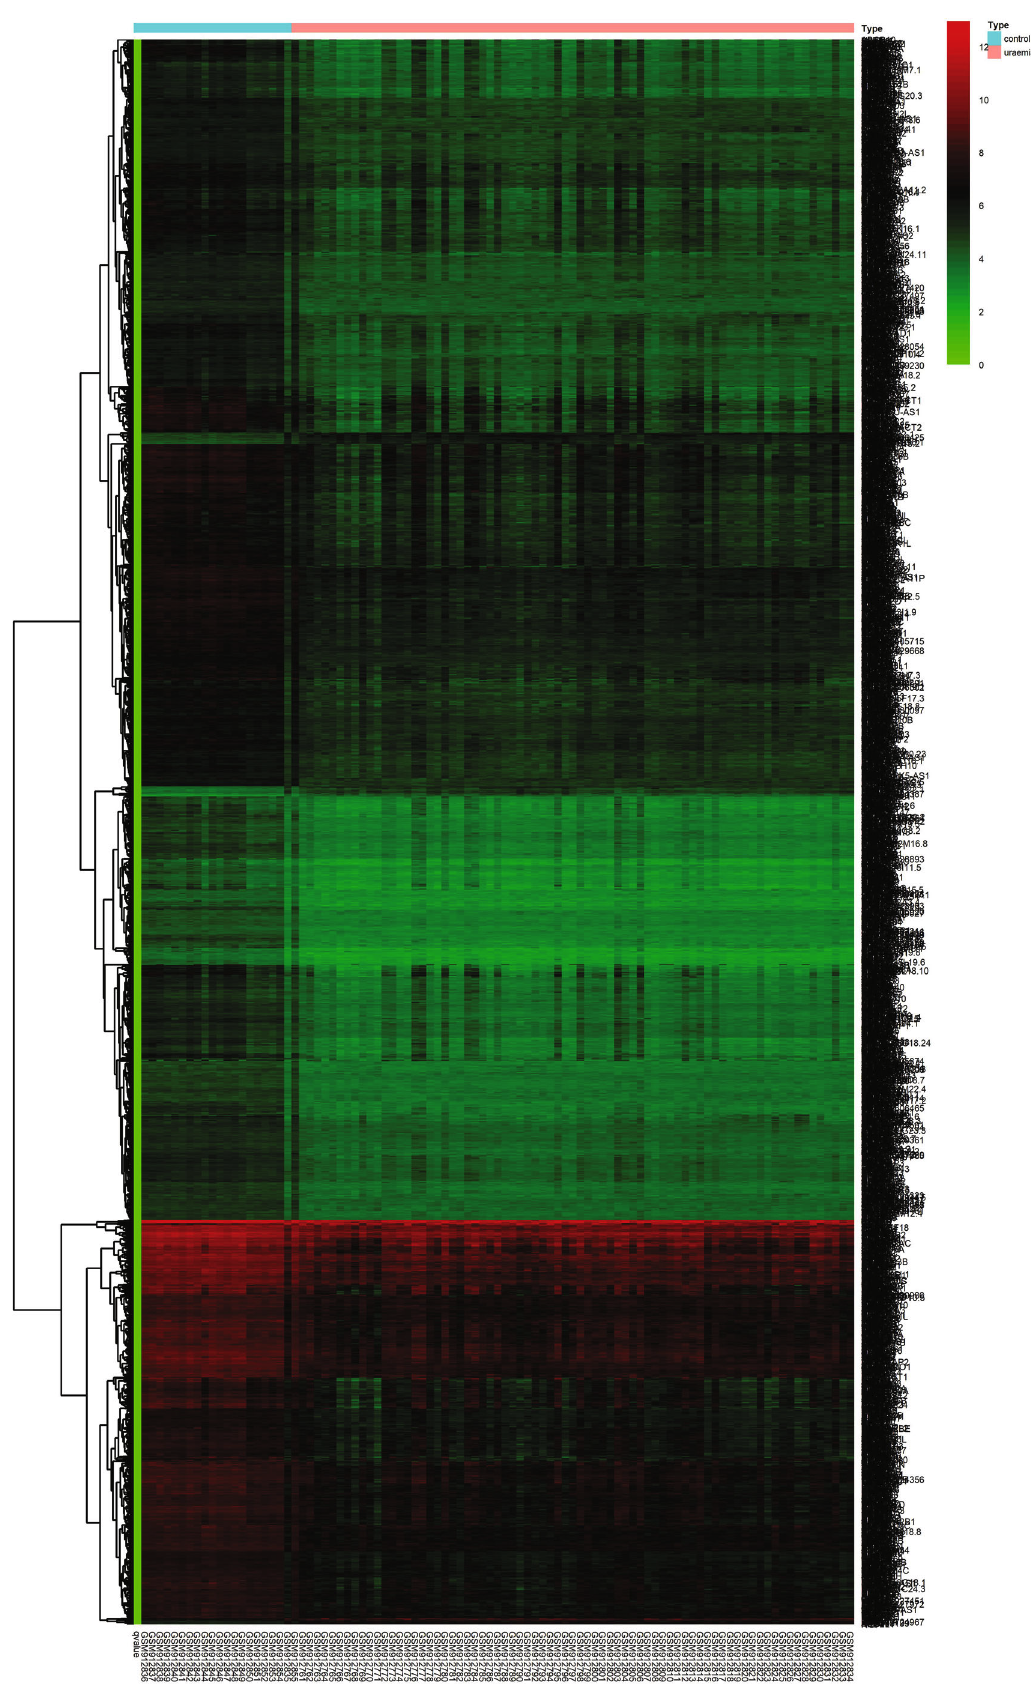
Figure 1: Heatmap of the top 3432 signi fi cant DEGs. Red and green indicate up-regulated and down-regulated gene